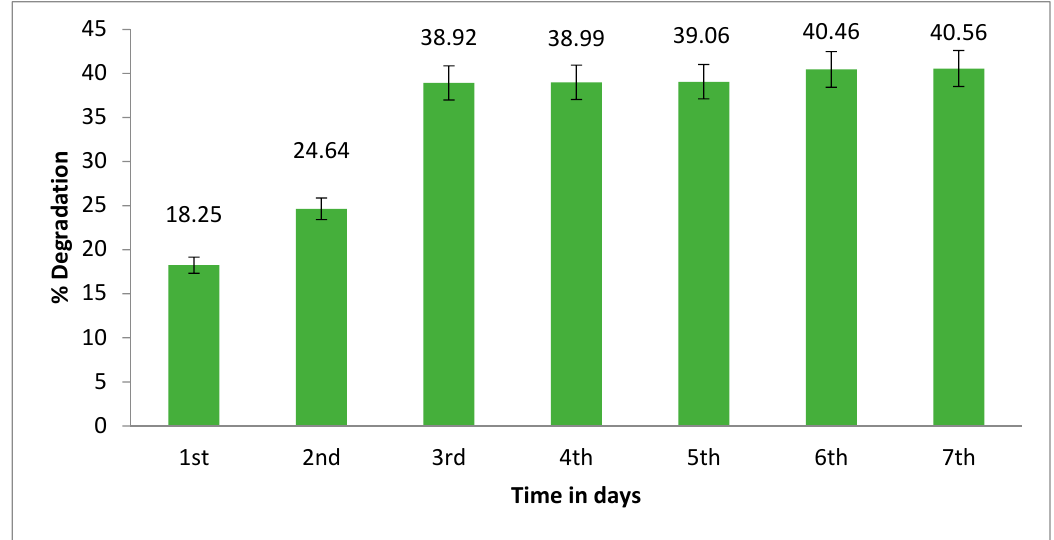
Figure 8. Effect of time in days on % degradation of brown